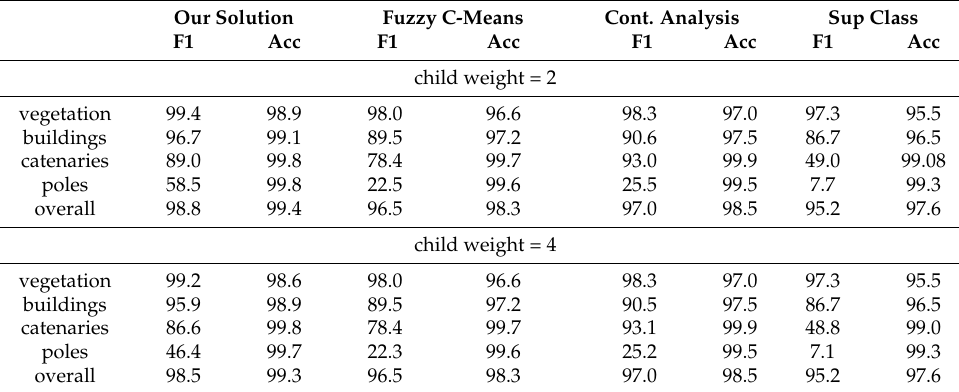
Table 6. F1 and accuracy for different child weight